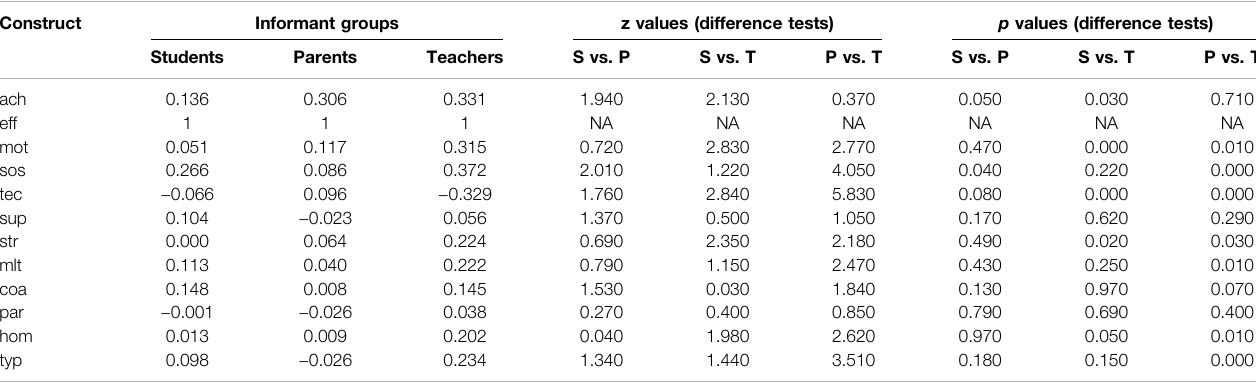
TABLE 5 | Latent correlations of the study variables with effort outcome. Construct